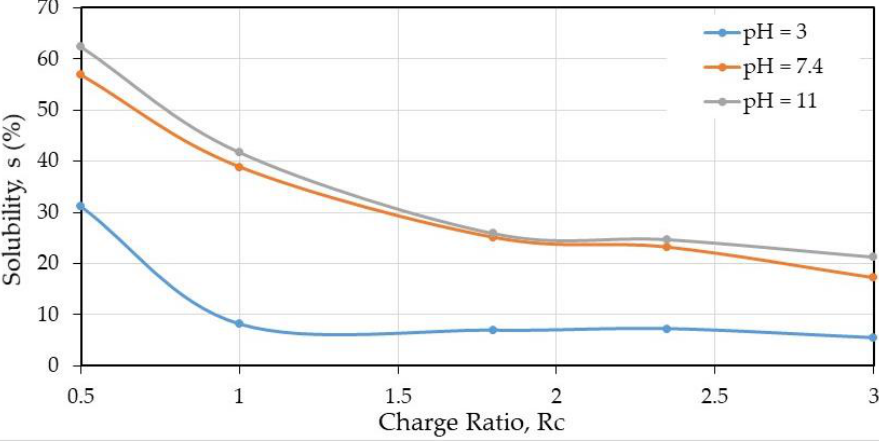
Figure 5. Partial solubility (%) at different pH on PEC films prepared in W/FA 50/50 v/v as a function of charge ratio.